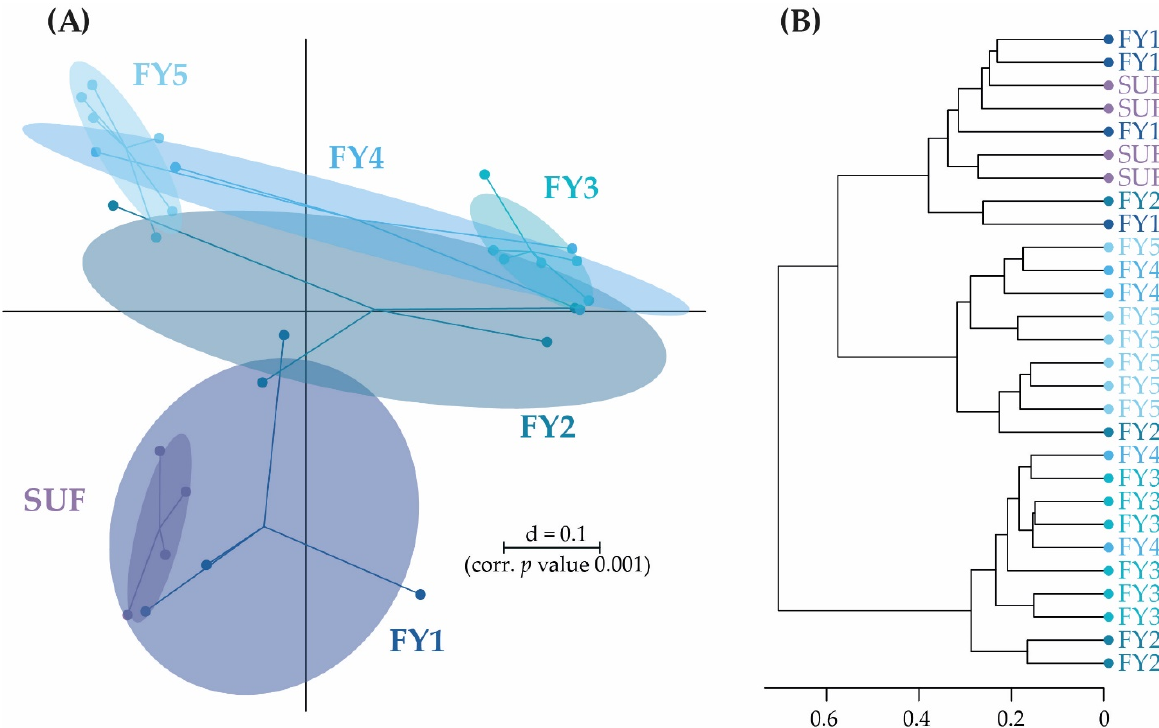
Figure 9. ( A ) β -diversity of late developmental stages’ BC is shown as a multidimensional-scaling (MDS) plot. The scale is an indicator for the variation in the taxonomic makeup of microbiota between samples ( β -diversity) based on generalized UniFrac distances (d = 0.1 marks a 10% difference). ( B ) Dendrogram of samples from early developmental stages based on wards clustering method (d = 0.1 marks a 10% difference). SUF, swim-up fry; FY1, fry 69 dpf; FY2, fry 74 dpf; FY3, fry 82 dpf; FY4, fry 88 dpf; FY5, fry 95 dpf; dpf, days post fertilization.